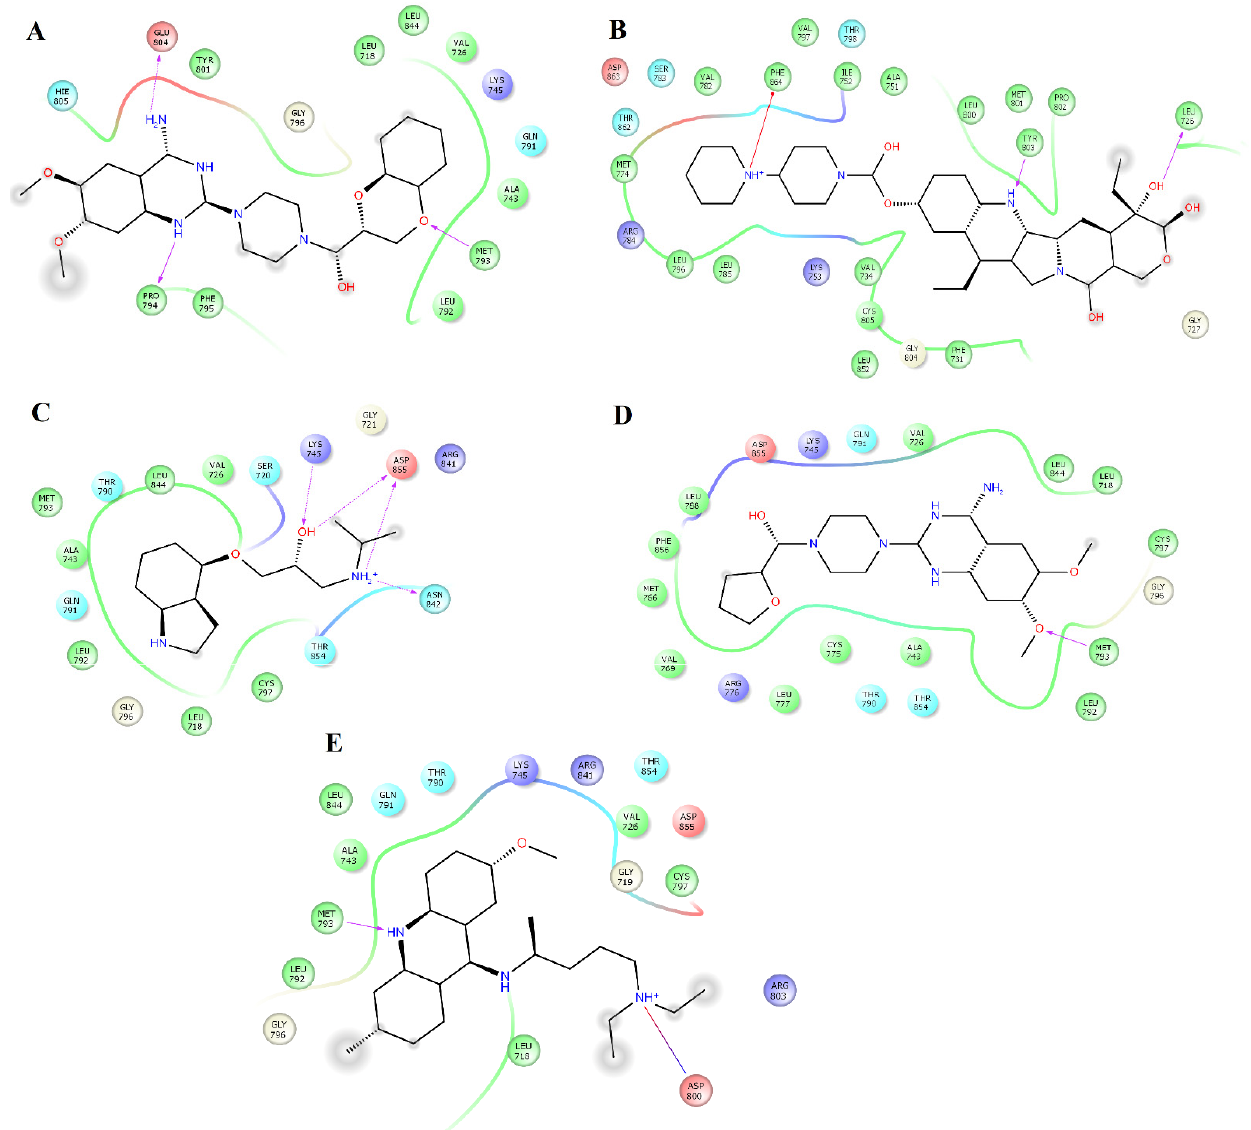
Figure 5. Interactions of the complexes between EGFR and doxazosin, pindolol, prazosin, quinacrine, and saprisartan. Binding complex for EGFR doxazosin ( A ); EGFR pindolol ( B ); EGFR prazosin ( C ); EGFR quinacrine ( D ) and EGFR saprisartan ( E ).